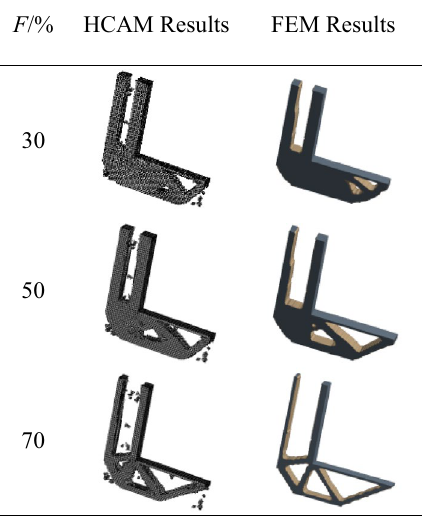
Table 1. Comparison of optimization results of different mass ratios.